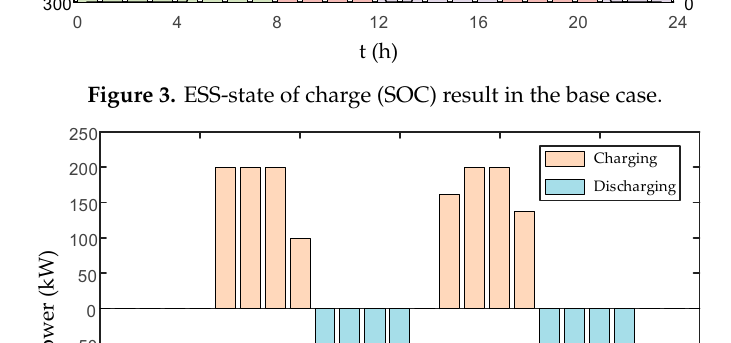
Figure 4. ESS charging and discharging results in the base case.